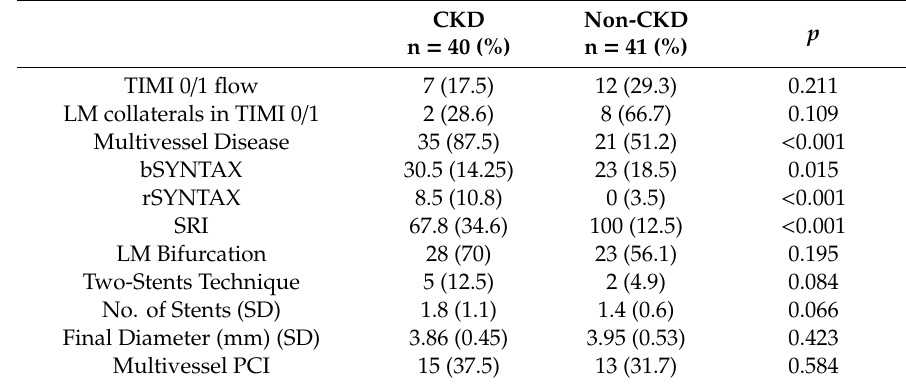
Table 2. Angiographic and procedural characteristics. Values are mean ± standard deviation, median (inter-quartile range), or number